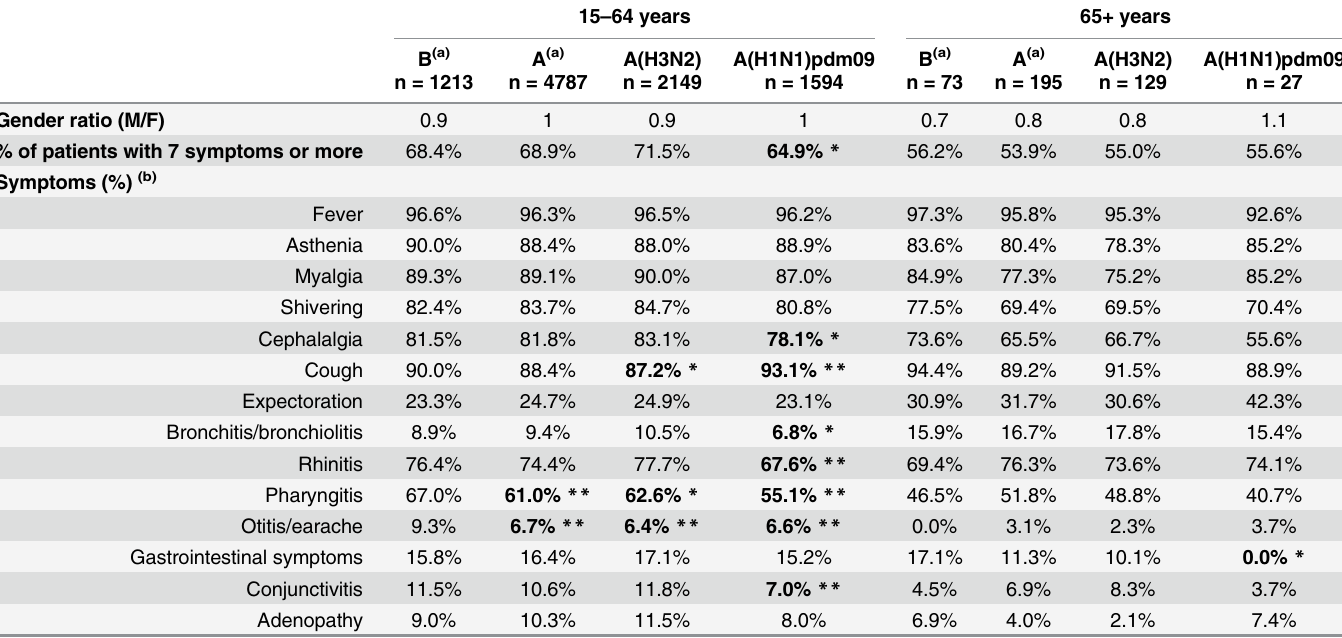
Table 3. Clinical presentation of influenza patients according to age group and influenza virus type and subtype in the age groups 15 – 64 years and 65 years or older. Univariate analysis. The IBVD (Influenza B in Vircases database) study, France, 2003 – 2004 to 2012 – 2013.